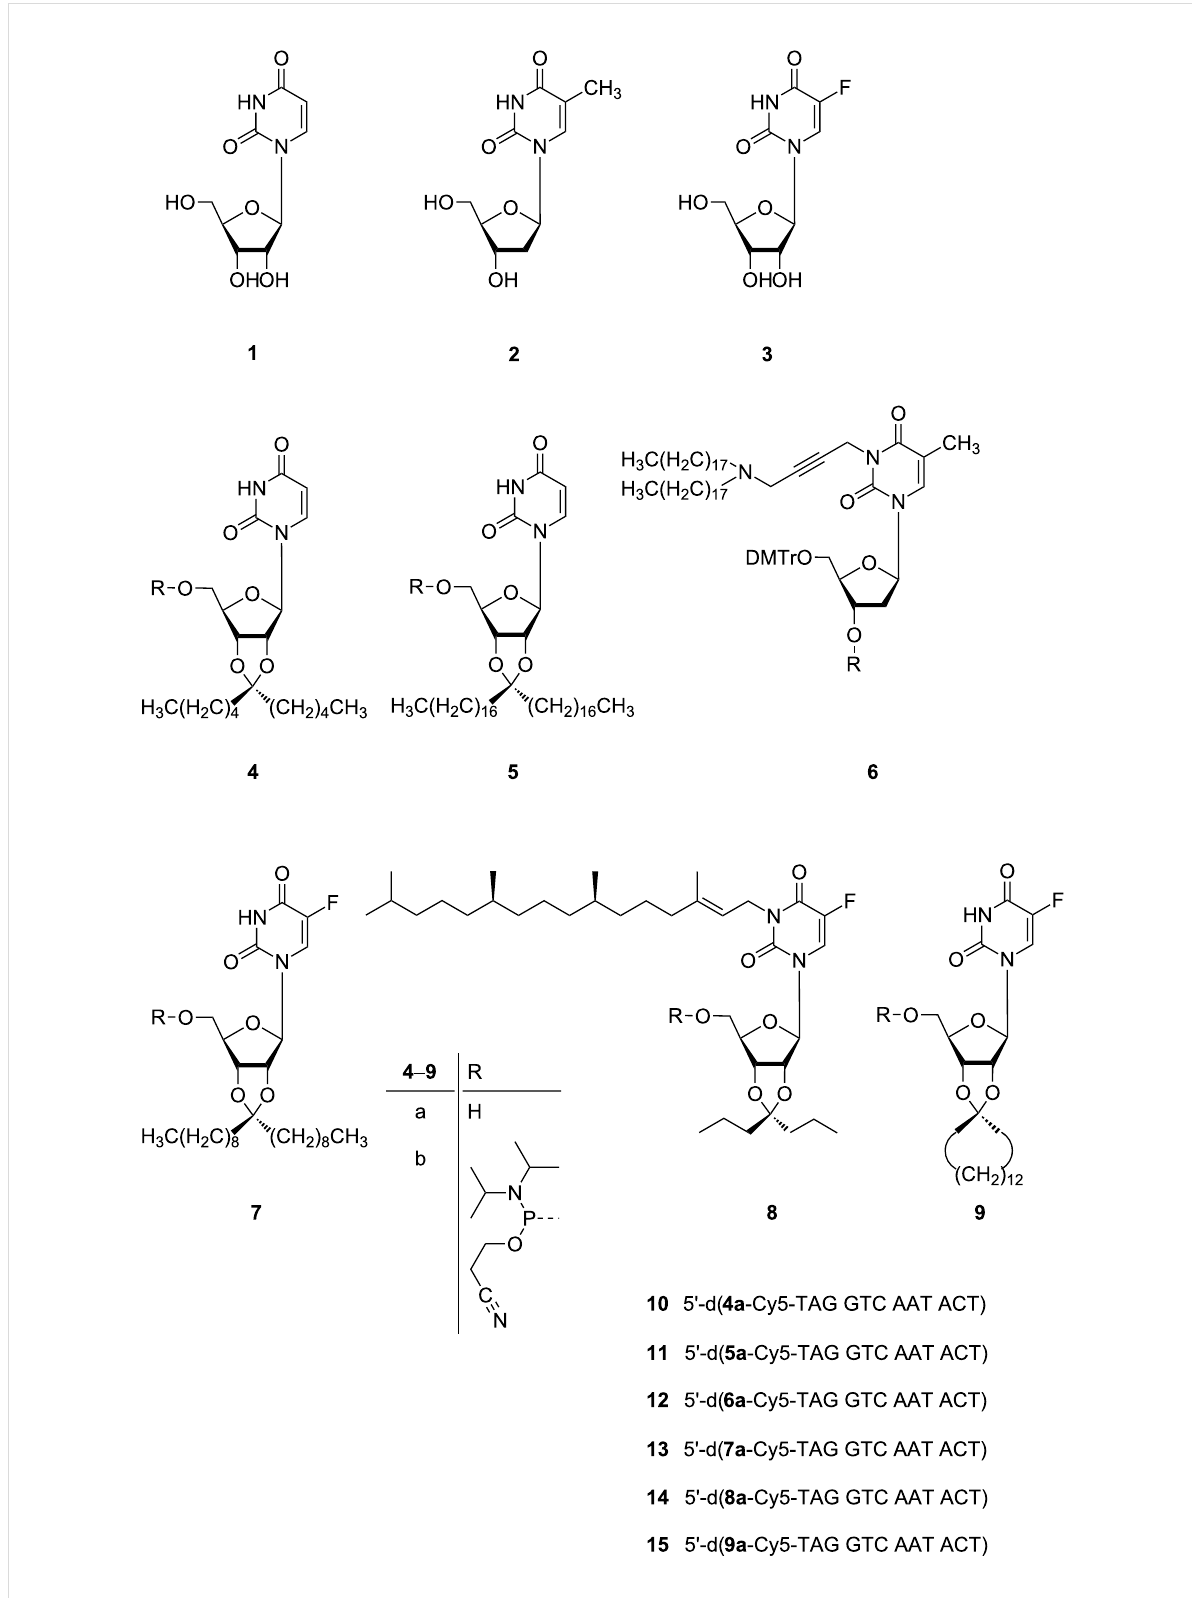
Figure 2: Chemical formulae 1 – 9 and lipo-oligonucleotide sequences 10 – 15